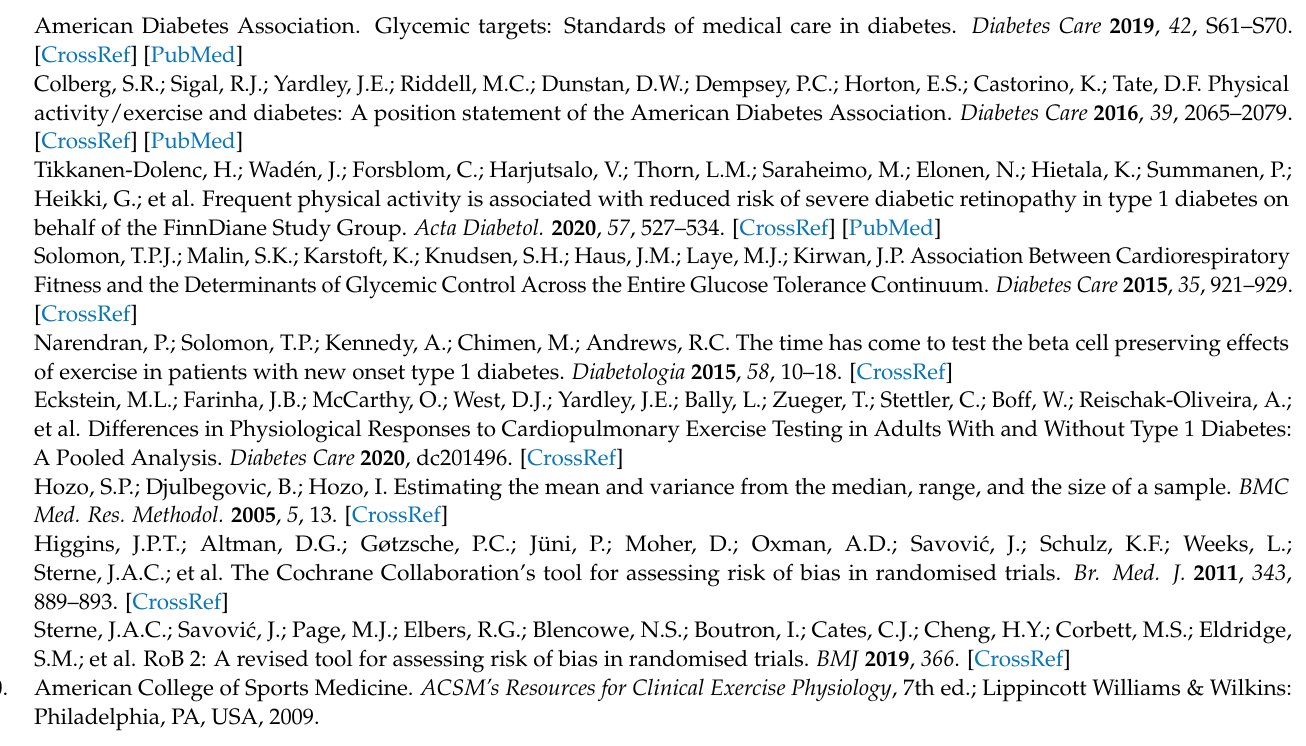
Table S1: Pubmed search, July 2020; Table S2: Embase search, July 2020; Table S3: Web of science search, July 2020; Table S4: Cochrane search, July 2020; Table S5: Statistical analysis of HbA1c of all included groups; Figure S1: Funnel Plot